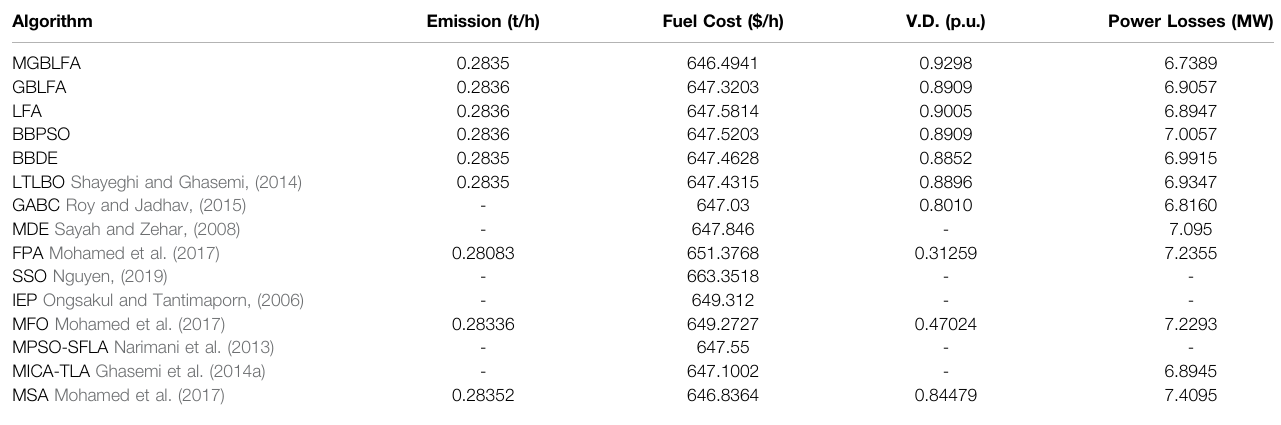
TABLE 3 | Comparison of optimal results by algorithms for Case 2. Algorithm